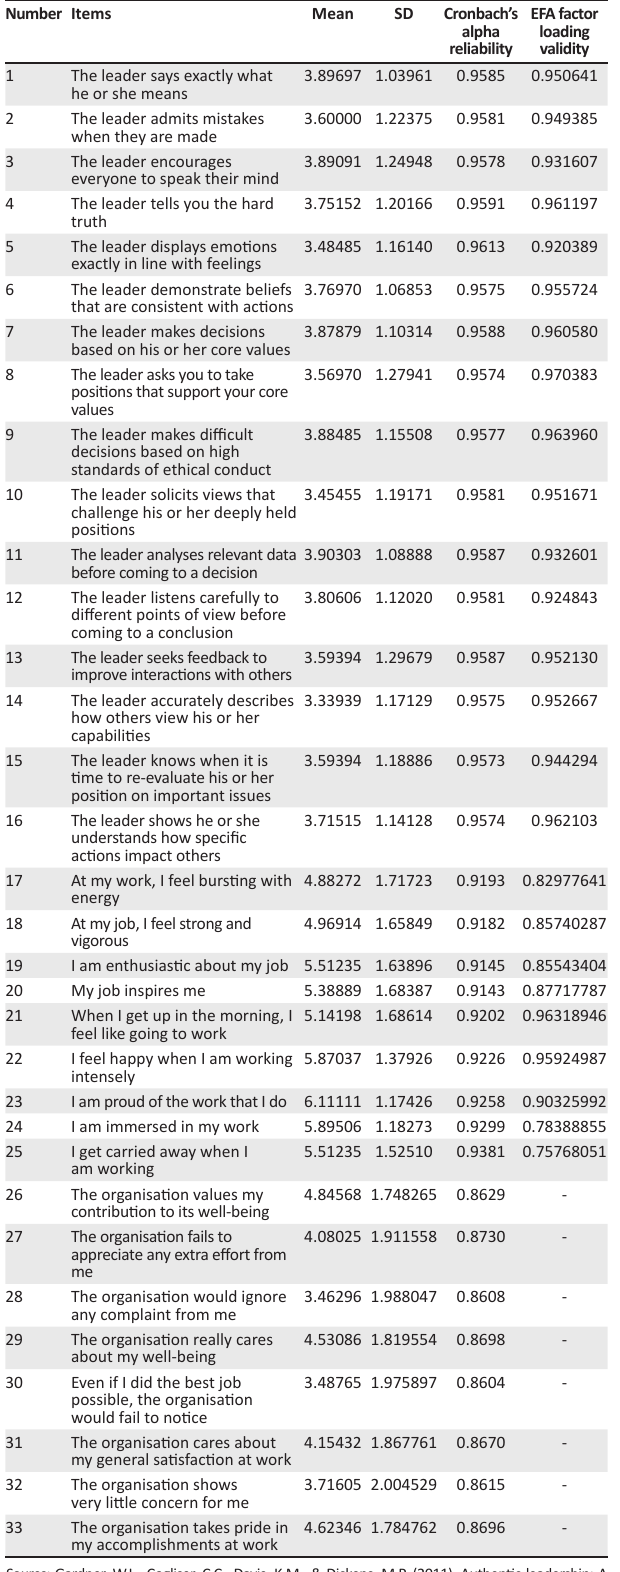
TABLE 1: Questionnaire items with mean, standard deviation, reliability and validity.